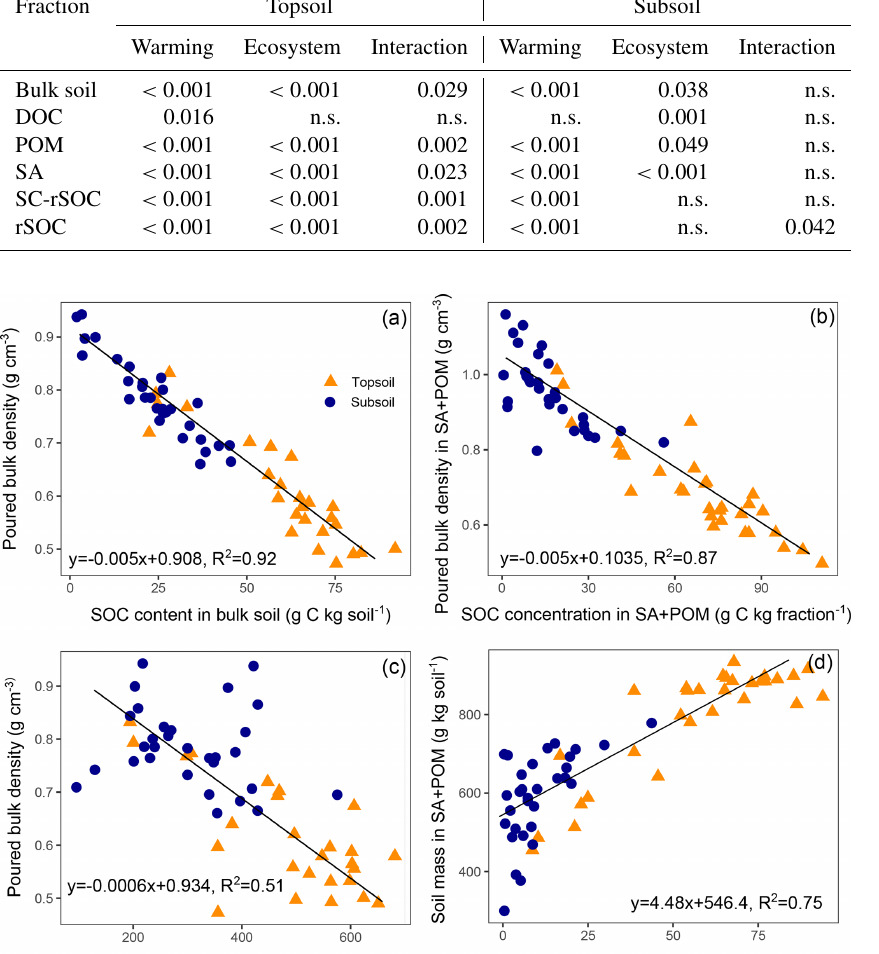
Figure 6. Poured bulk density as a function of the soil organic carbon (SOC) content in (a) the bulk soil and (b) the coarse ( > 63µm) soil fraction (sand and stable aggregates, SA, and particulate organic matter, POM); (c) the poured bulk density as a function of soil mass in aggregates and (d) soil mass in the coarse soil fraction as a function of SOC mass in the coarse soil fraction with regression models fitted to all observations ( p < 0 . 001 for all